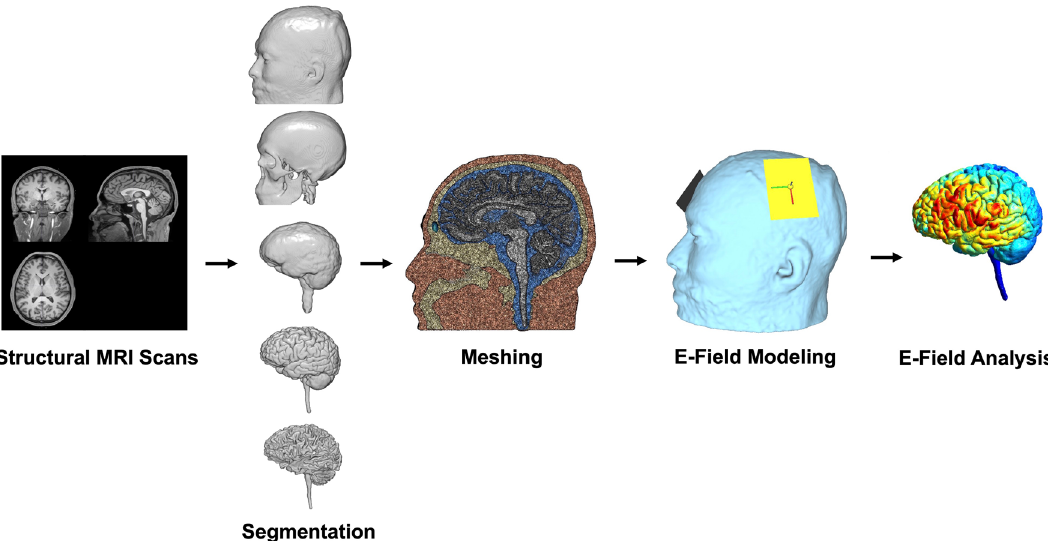
Figure 1. E-Field Modeling Pipeline. E-field modeling entails five main steps. First, the researcher acquires structural MRI scans (i.e., T1w and T2w scans). Next, the structural MRI scans are segmented into different components (top to bottom: skin, bone, cerebrospinal fluid, grey matter, and white matter). Third, the tissue segmentations are combined into a 3D volumetric mesh to create an anatomically accurate head model. Fourth, E-field modeling uses experimentally determined tissue conductivity values to simulate how much electric current applied at the scalp reaches the cortex. Displayed is an example in which 7 × 5 cm electrodes were placed over the left primary motor cortex (M1) and right supraorbital (SO) cortex. Lastly, the researcher performs E-field analyses. See Fig. 2 for detailed description of E-field analyses in this study, which included a region